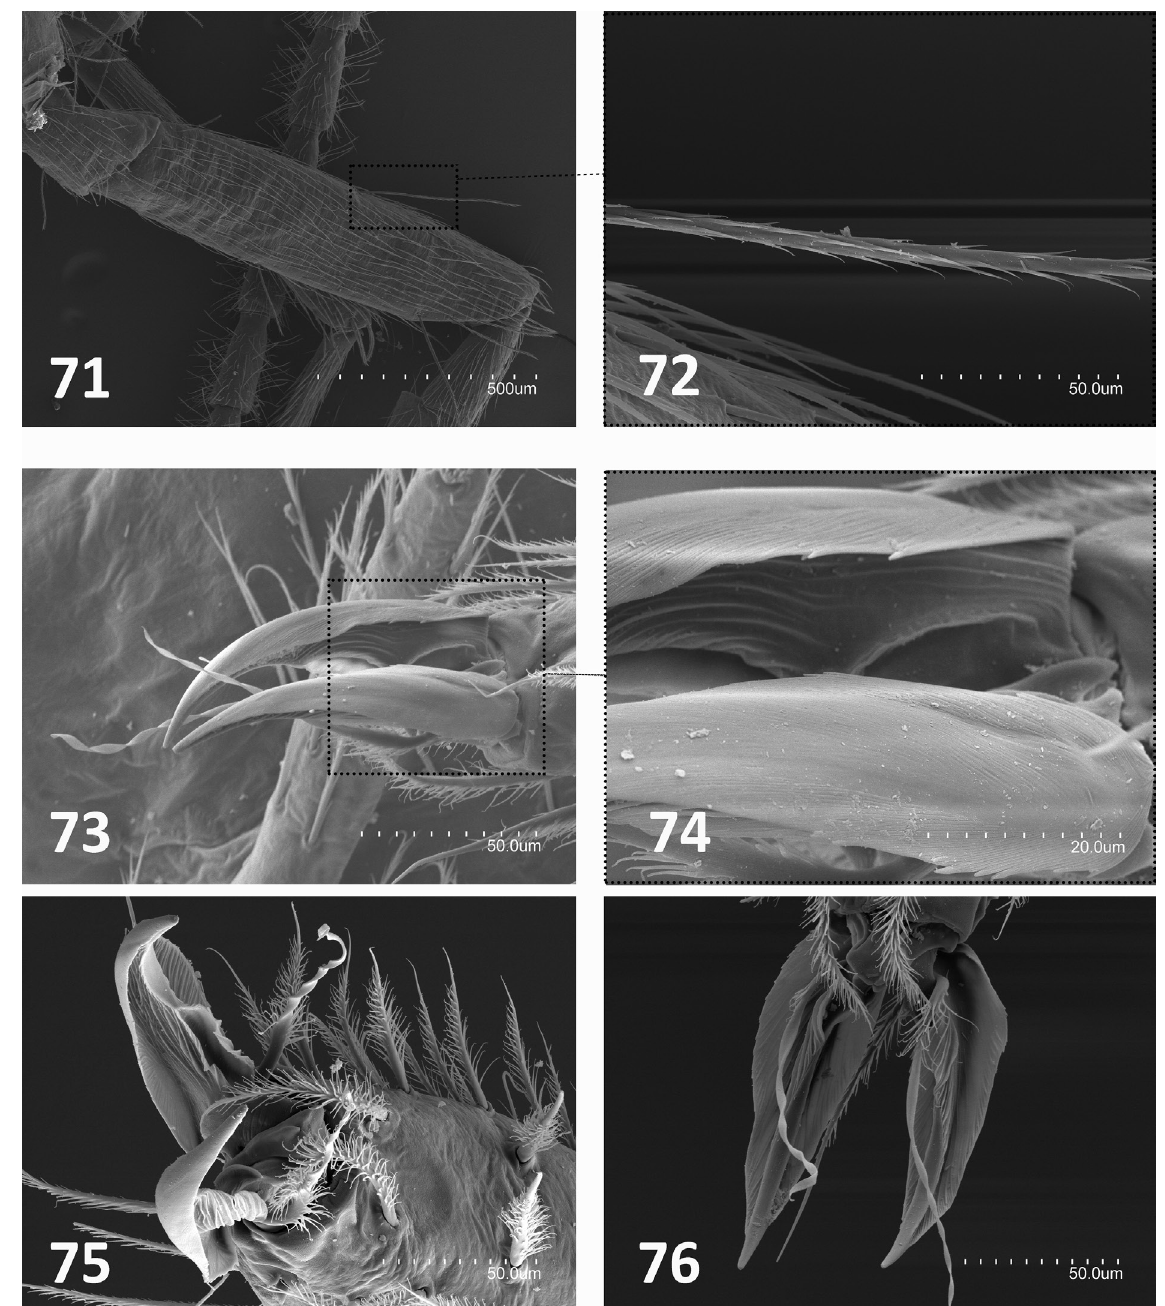
Figs 71–76. Plusiocampa ( Plusiocampa ) hoffmanni Sendra & Paragamian sp. nov., from Varathro Stou Bokou ton Poro, Krousonas, Crete (71–74) and Varathro Mythia Kabathoura, Rethymno, Crete (75–76) (Coll. AS). 71 . Femur of metathoracic leg. 72 . Dorsal femoral macroseta, metathoracic leg. 73 . Dorso- lateral view of pretarsus, posterior claw in the foreground. 74 . Detail of preceding, posterior claw in the foreground. 75 . End of tarsus, with pretarsus in ventral view. 76 . Pretarsus, ventral